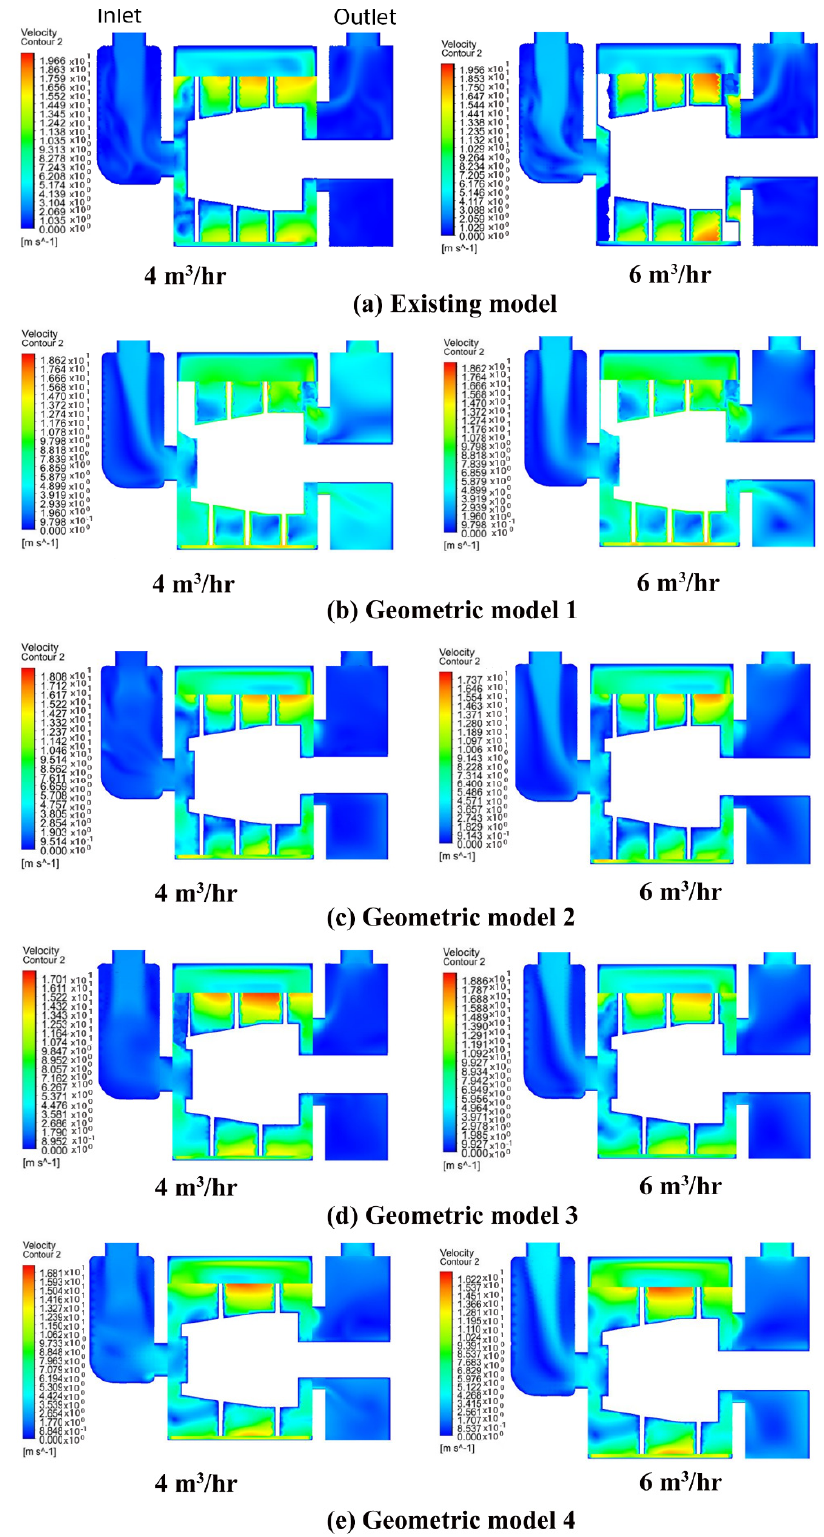
Figure 16. Variation of velocity in different geometric models ( a ) Existing model ( b ) Geometric model 1 ( c ) Geometric model 2 ( d ) Geometric model 3 and ( e ) Geometric model 4. The velocity contours shown in Figure 16a–e clearly indicate the differences in the flow behaviour within the pump with the change in the number of blades. Existing pumps